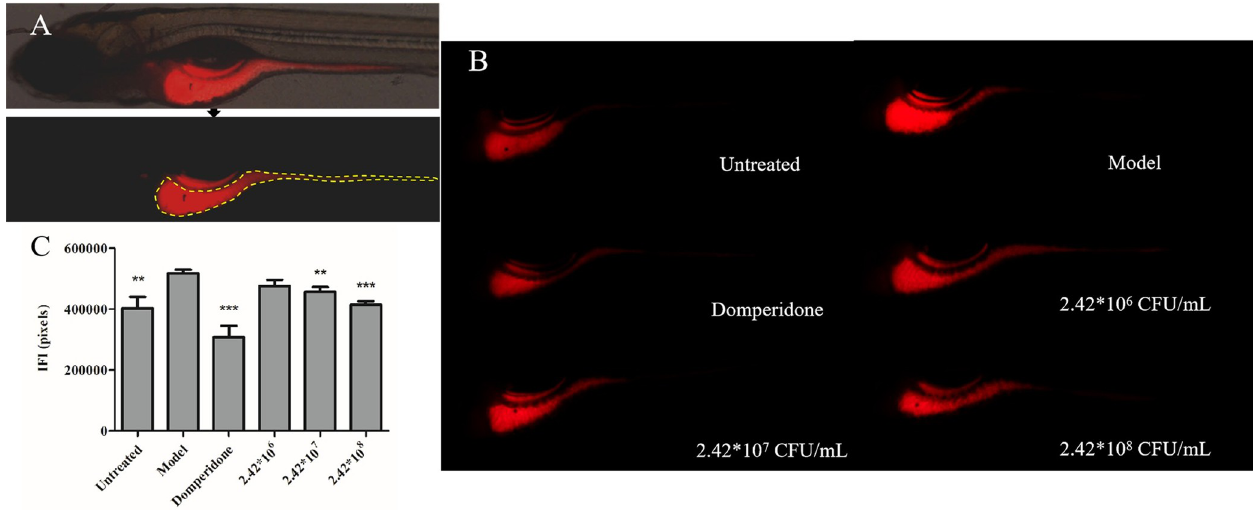
Fig 2. The therapeutic effects of B . lactis BL-99 on the larval zebrafish intestinal motility and constipation. Schematic diagram of the intestinal fluorescent B . lactis BL-99 and analysis area of the larval zebrafish (A). The nile red fluorescent intensity (B) and quantitative analyses (C) in the larval zebrafish intestines. Data were expressed as means ± S.E.M. Compared with the model group, �� p < 0.01, ��� p < 0.001. IFI = intestinal fluorescent intensity.